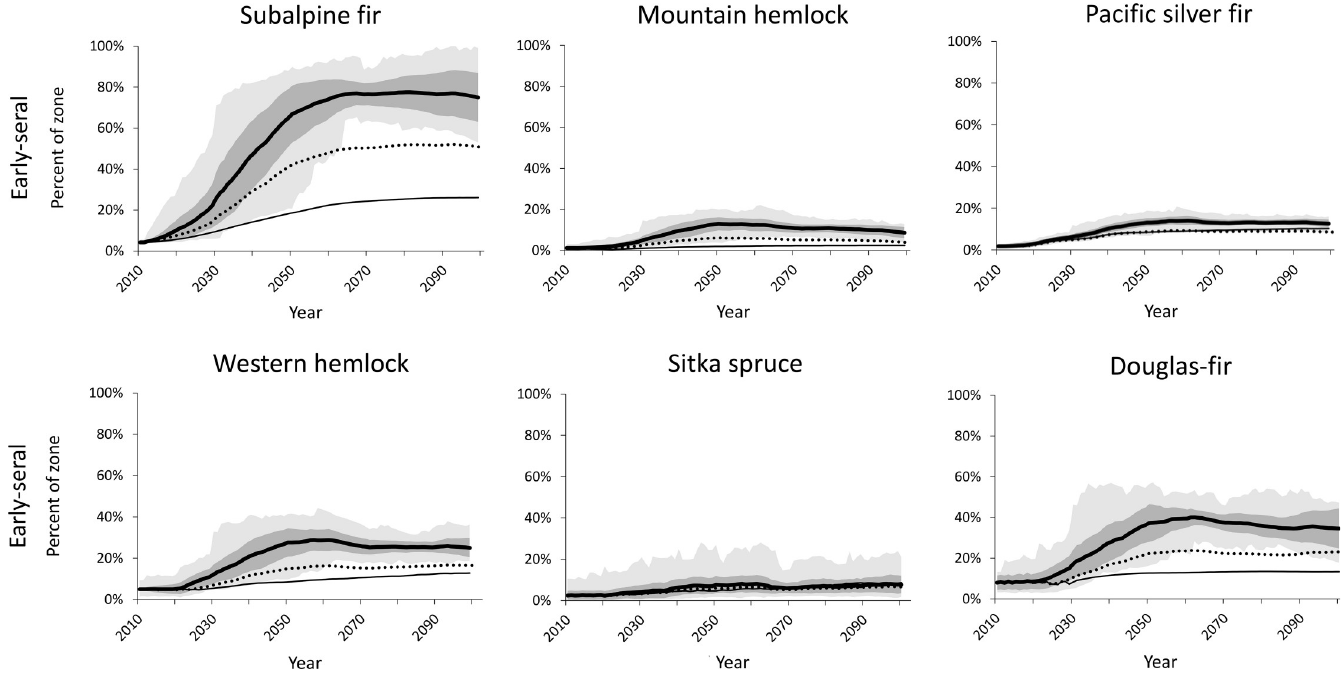
Fig 8. Projected trends and variation in early-seral conditions under difference climate and fire exclusion assumptions. Partial fire exclusion assumes a 50% reduction in area burned. Note y-axes have different scales and some lines have near-complete overlap. See Fig 7 for legend.